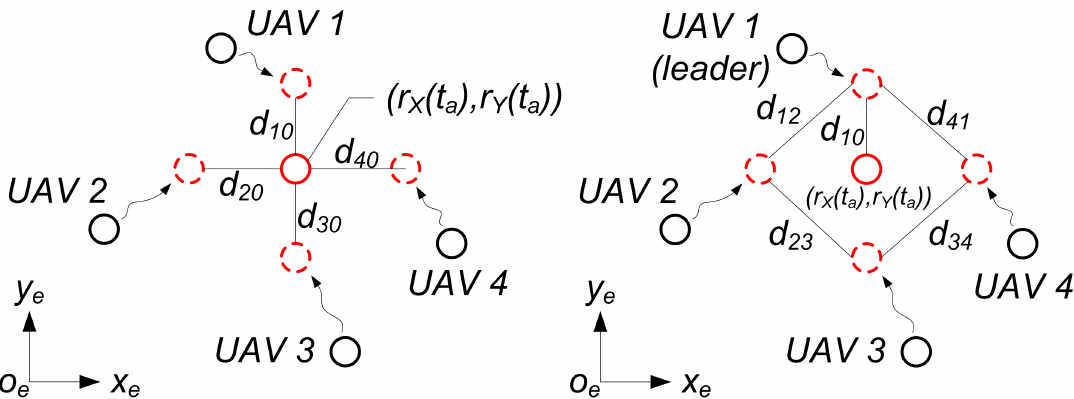
Figure 1. Left : Intuitive desired motion trajectories for quadrotors. Right : Available desired motion trajectories using neighbor-based